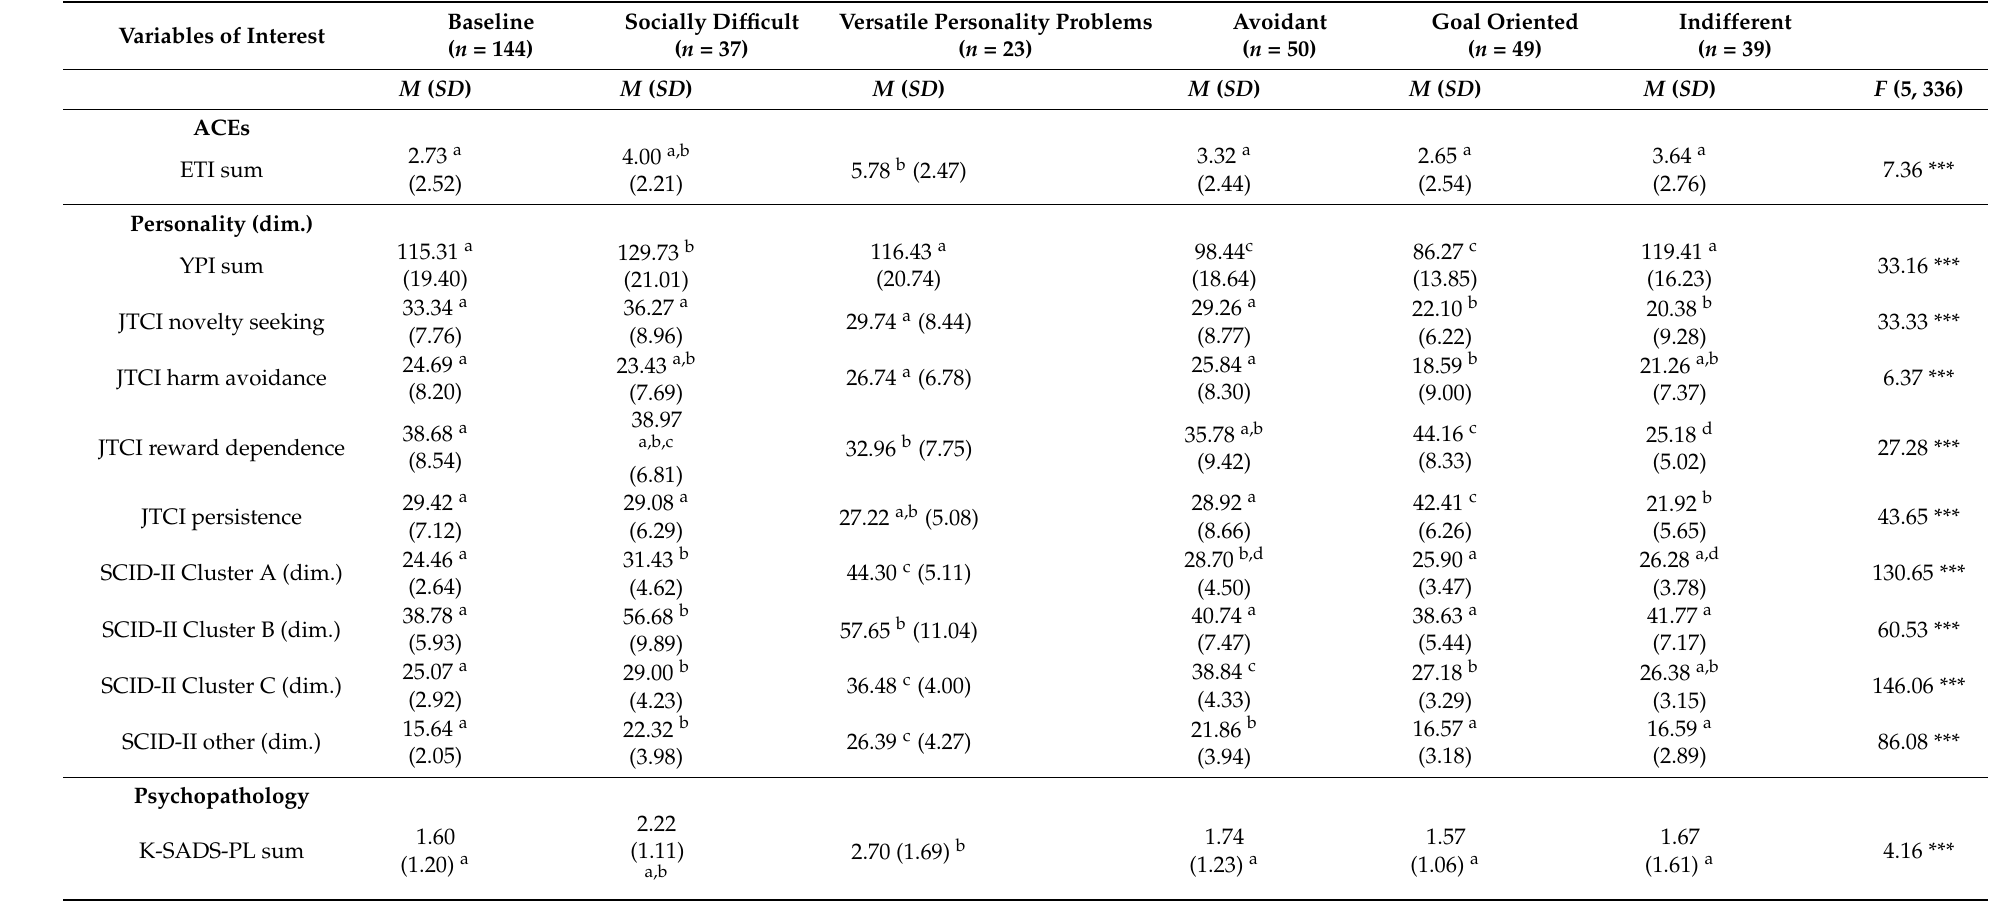
Table 2. Main variables of interest in the six distinct personality